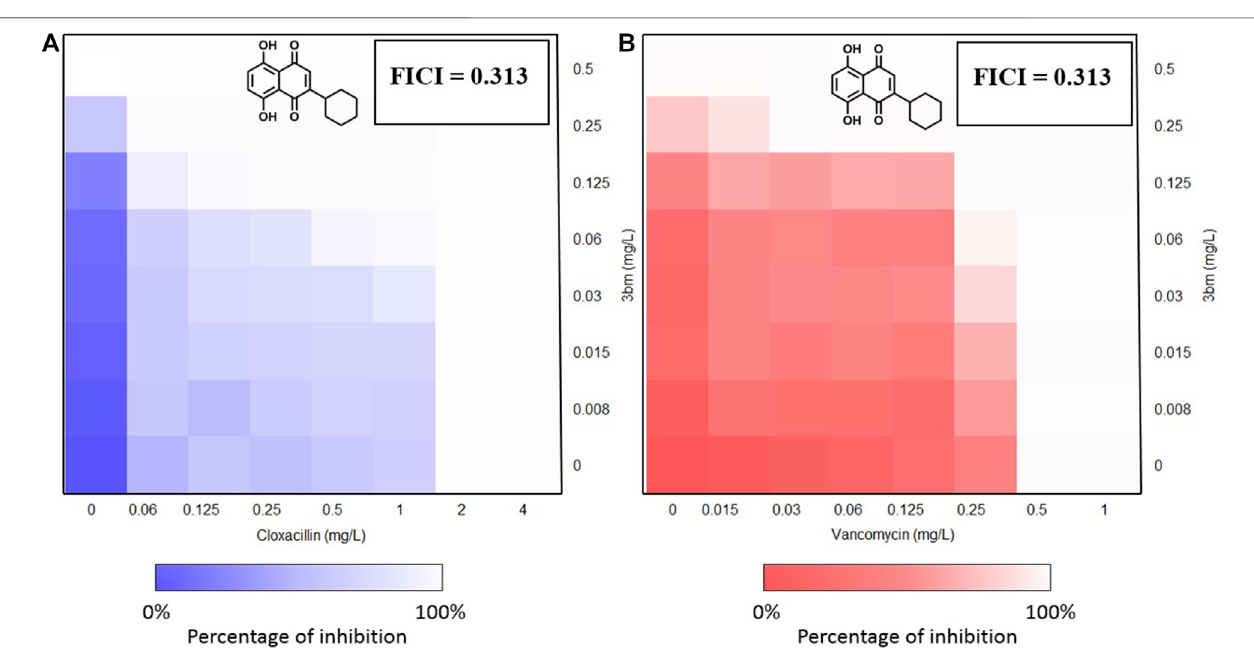
FIGURE 6 | Heat maps of FICI measurements of 3bm in association with cloxacillin (A) and vancomycin (B) . FICI calculations were realized at constant concentration when possible.